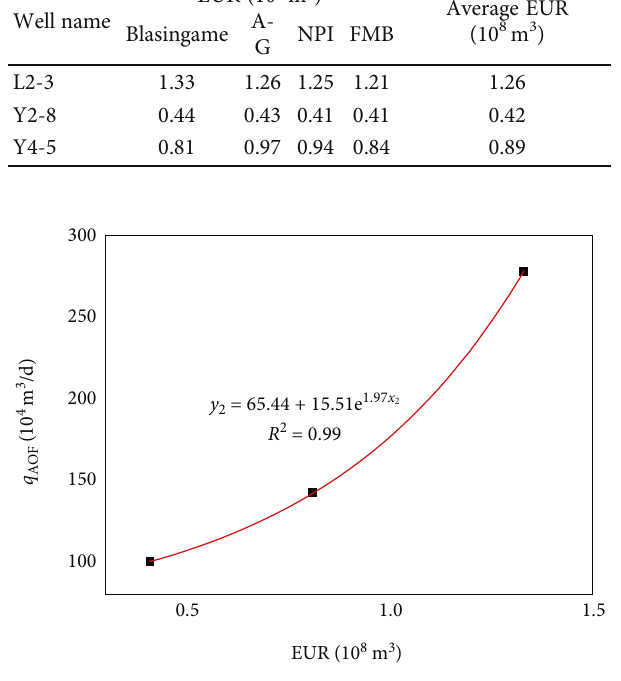
Figure 11: Relationship curve between AOF and EUR of three gas